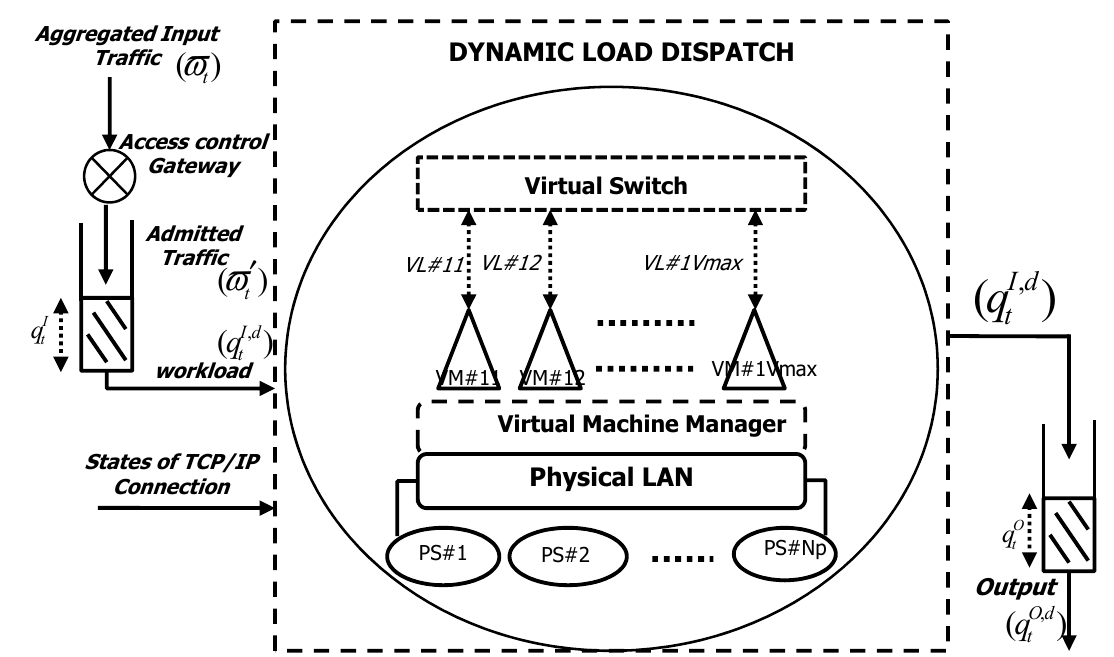
Figure 4. General architecture of a Virtualized Fog Computing Node (FCN). (PS = Physical Server, VL = Virtual Link, VM = Virtual Machine).